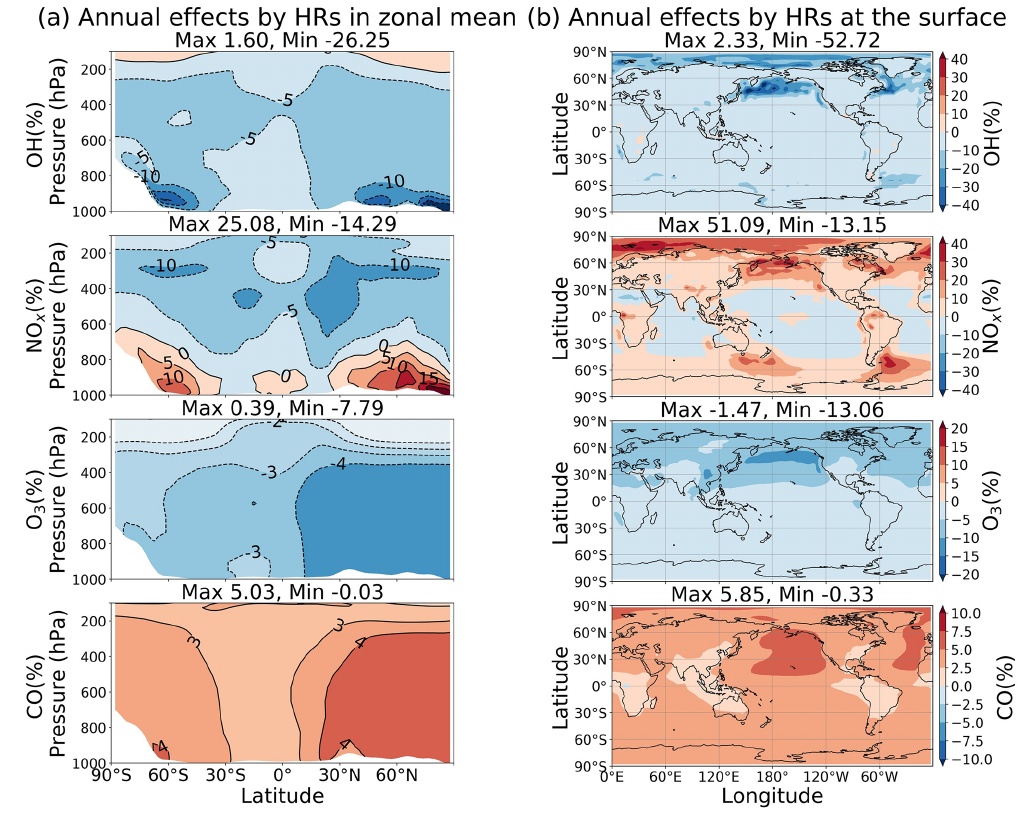
Figure 14. Annual zonal mean (a) and surface (b) total HR